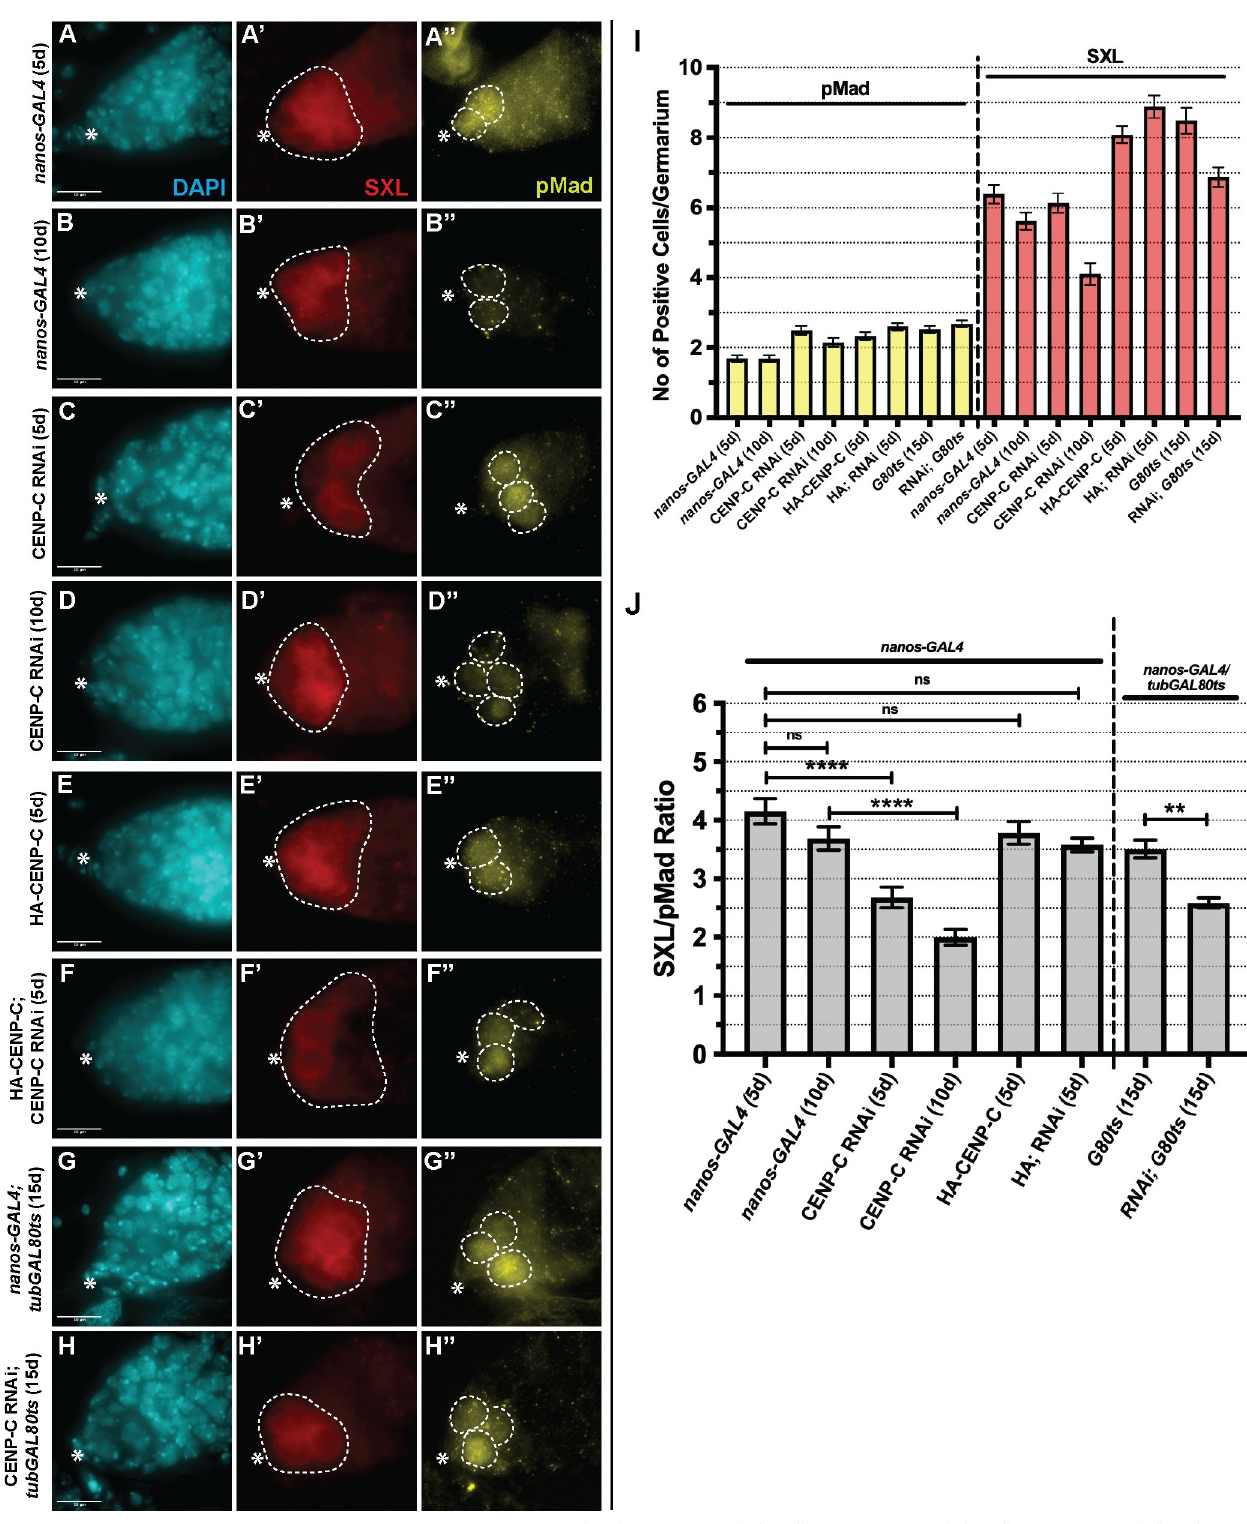
Fig 6. CENP-C depletion shifts GSCs toward a self-renewal tendency. (A-F) nanos-GAL4 (5d, 10d), CENP-C RNAi (5d, 10d), HA-CENP-C (5d) and HA-CENPC;CENPC RNAi rescue (5d) germaria and (G) nanos-GAL4; tubGAL80ts (15d), (H) CENP-C RNAi; nanos-GAL4; tubGAL80ts (15d) germaria stained with DAPI (cyan), SEX-LETHAL (SXL, red) and pMad (yellow). Scale bar = 10 μ m. � denotes cap cells. White dashed circles highlight SXL or pMad